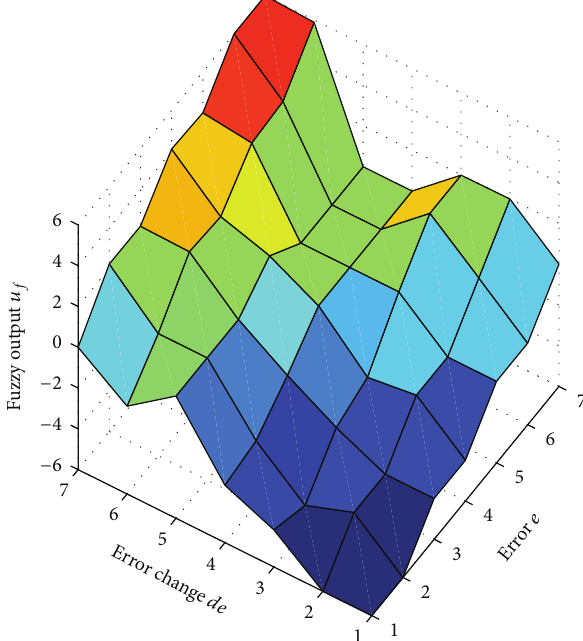
Figure 19: The control surface after adjusted NFC.